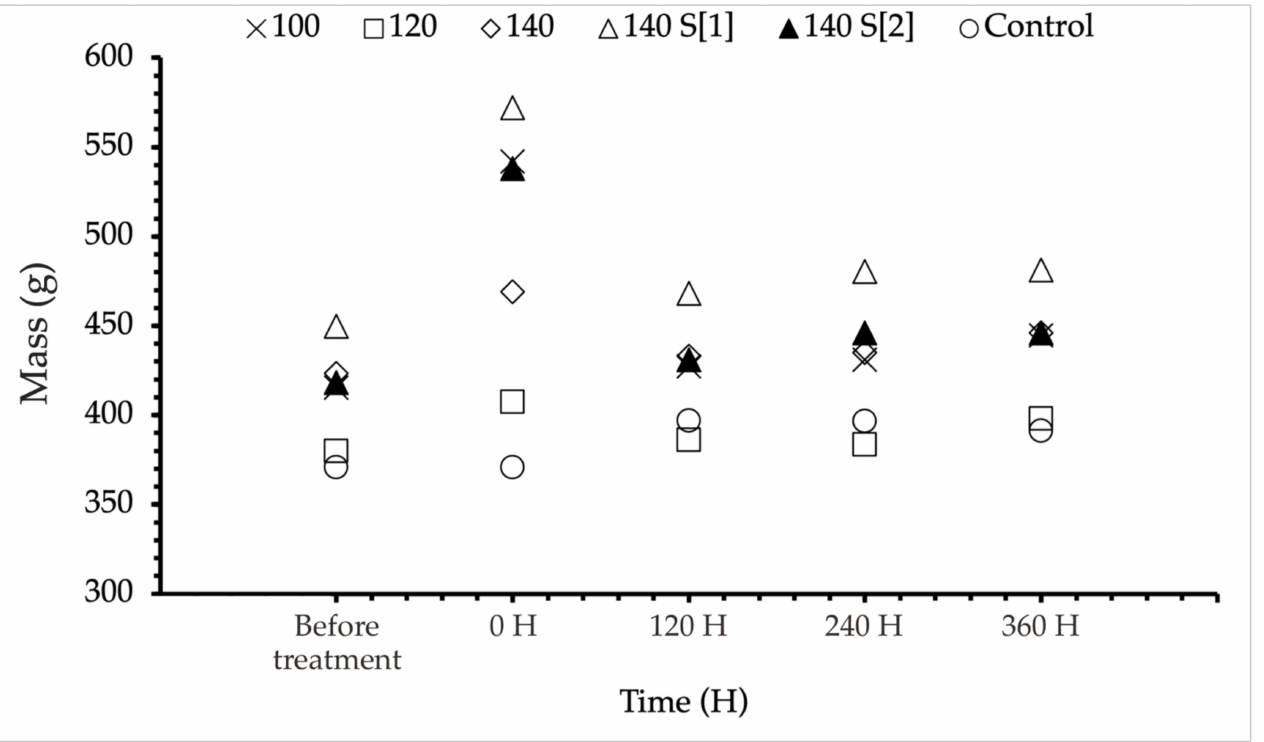
Figure 4. Mass change of specimens.